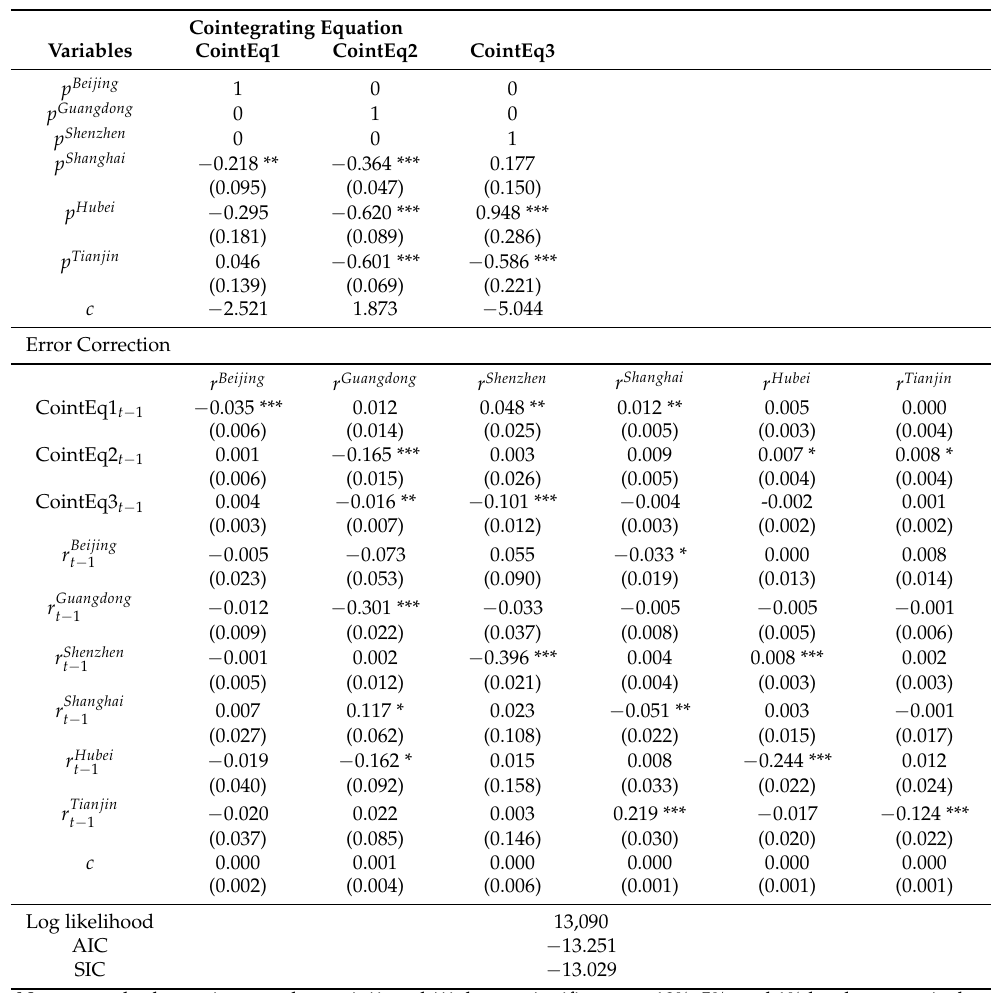
Table 4. VECM estimation result for the whole